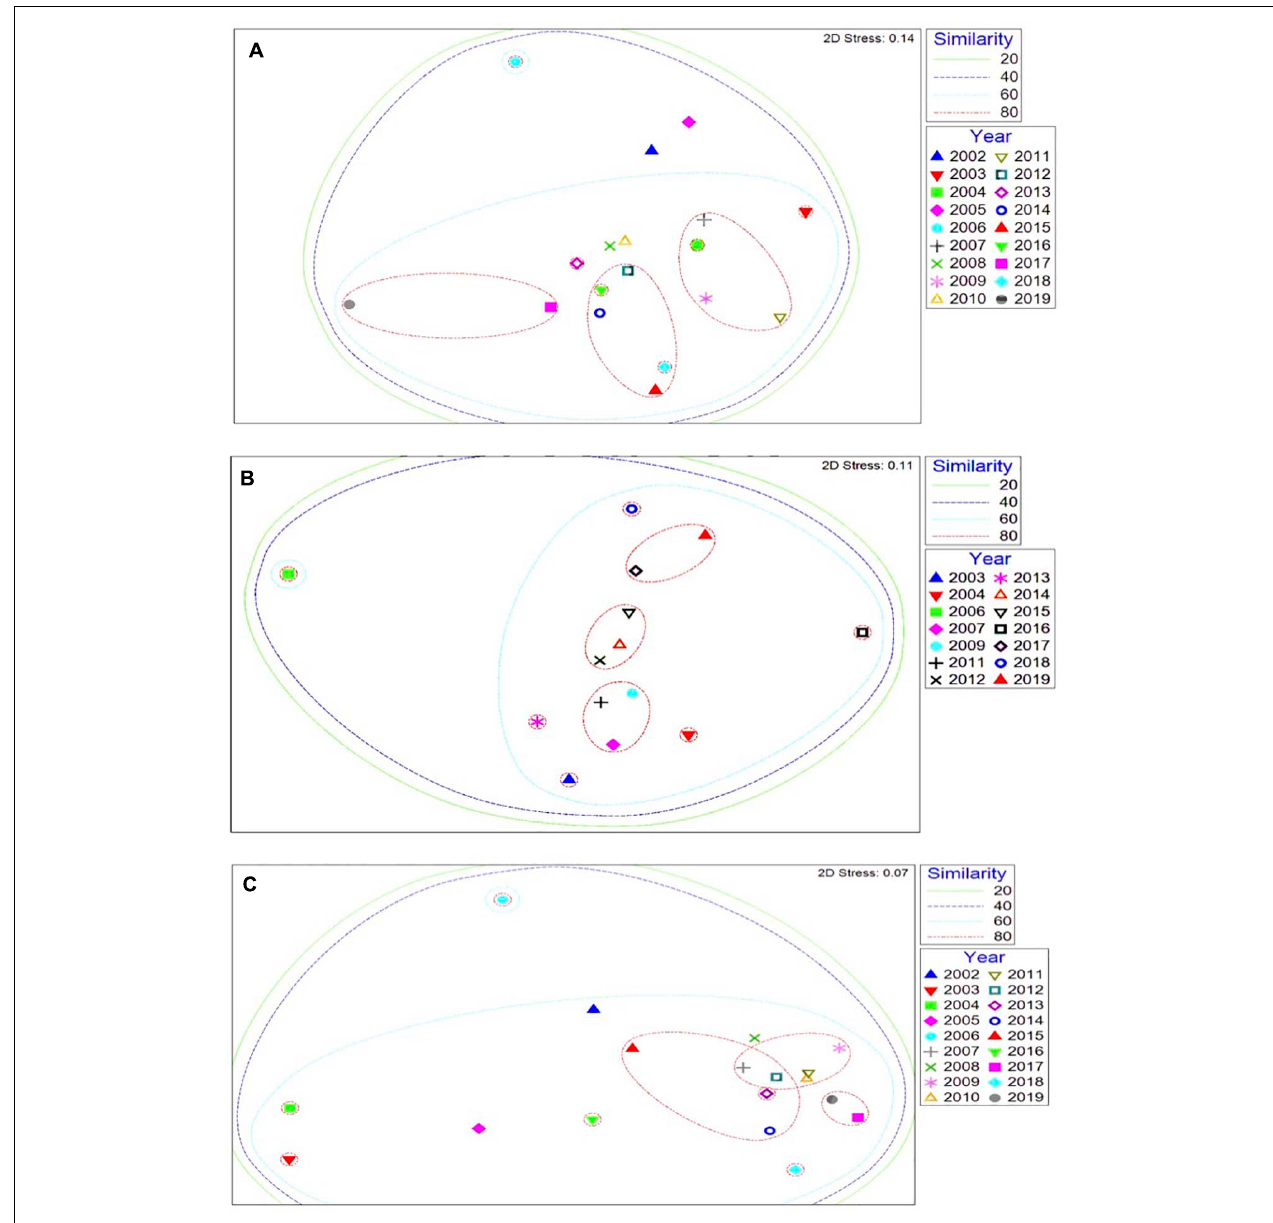
FIGURE 10 | Multi-dimensional scaling ordination of MarClim community data at (A) St. Ives, (B) Crackington Haven, and (C) Trevone over the long-term time-series 2002–2019. Based on Bray Curtis similarity coefficient, non-standardised data and square root transformed